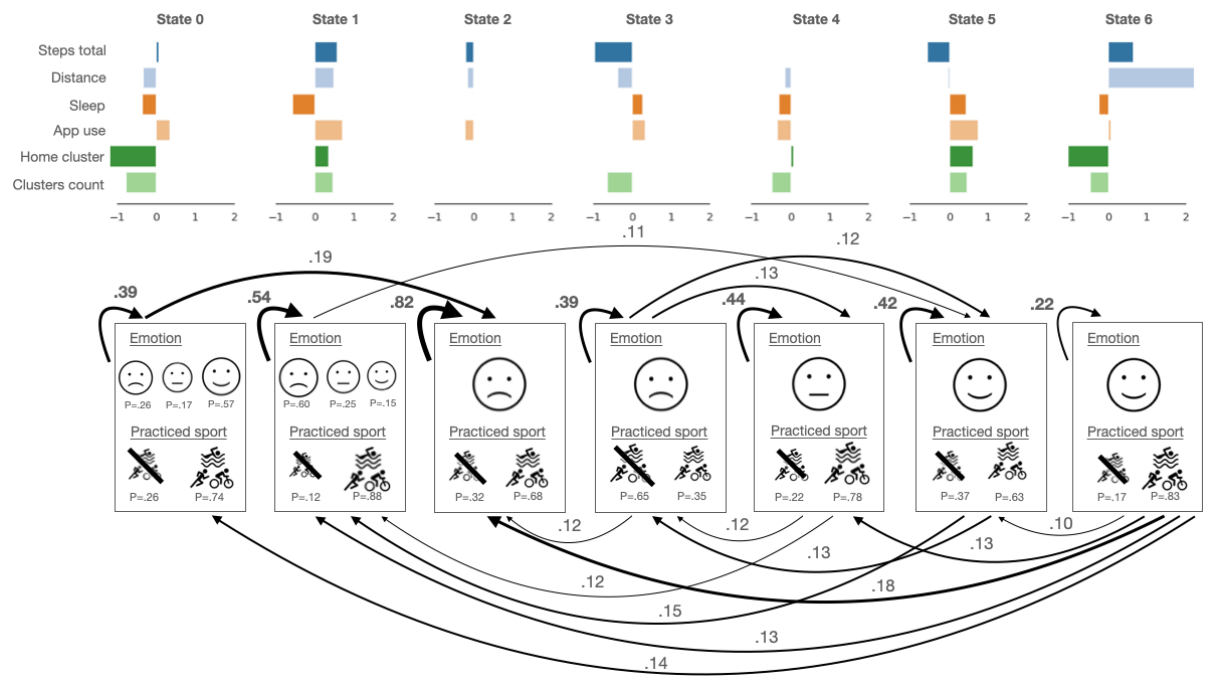
Figure 3. The 7-component hidden Markov model structure was used for emotional valence modeling with each Gaussian mean in each component and indicating discrete emission probabilities. The size of the icons indicates the magnitude of the discrete emission probabilities (emotion and sport). Only the transitions with a higher than 0.1 probability are shown in the graph. In terms of features, "steps total" refers to step count, "distance" refers to the distance traveled, "sleep" refers to the hours of sleep, "app use" refers to the hours spent using different apps, "home cluster" refers to the time spent at home, "clusters count" refers to the number of visited locations, and "practiced sport" is an indicator of whether the patient practiced any sports. Of note, the negative mean values were a result of the normalization of the features.